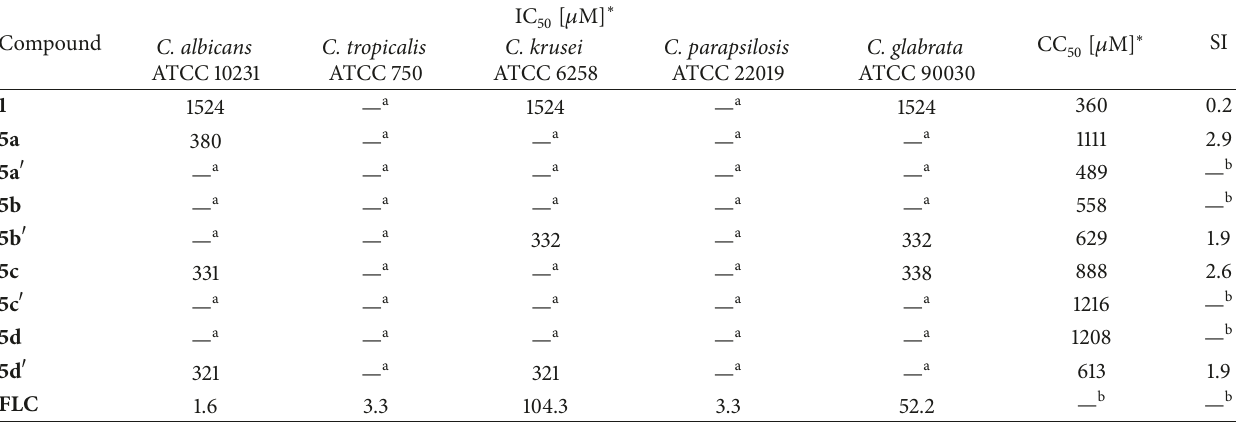
Table 1: In vitro antifungal activity (IC 50 , 𝜇 M), cytotoxic activity (CC 50 , 𝜇 M), and selectivity index for eugenol (1) and related benzoxazole derivatives (5a–5d 󸀠